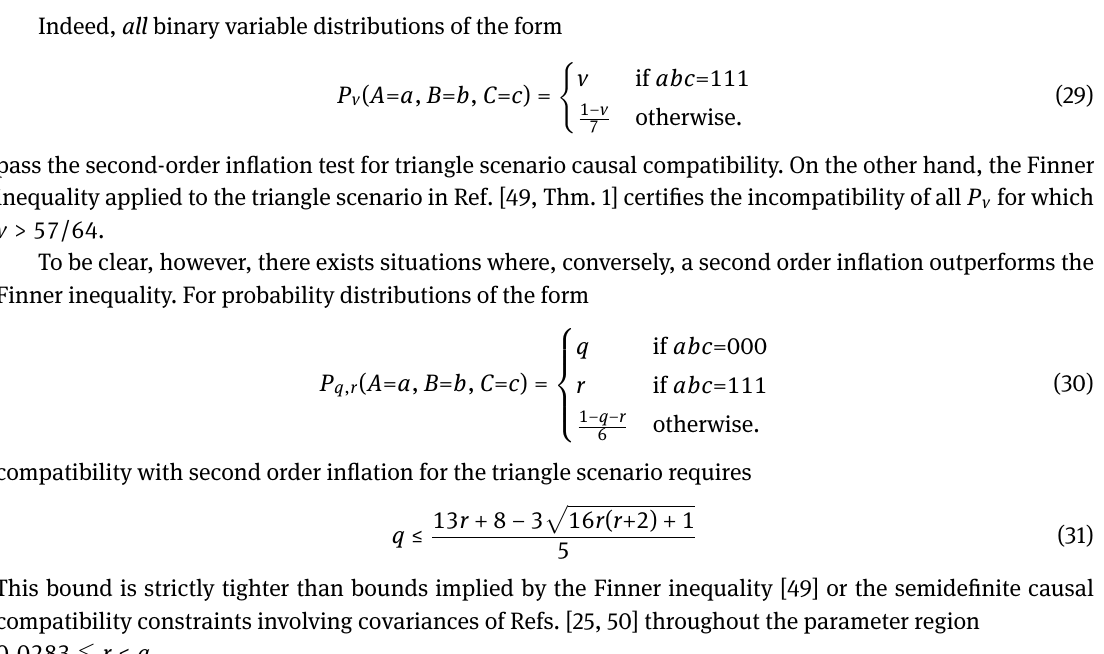
Figure 8: The four-on-line correlation